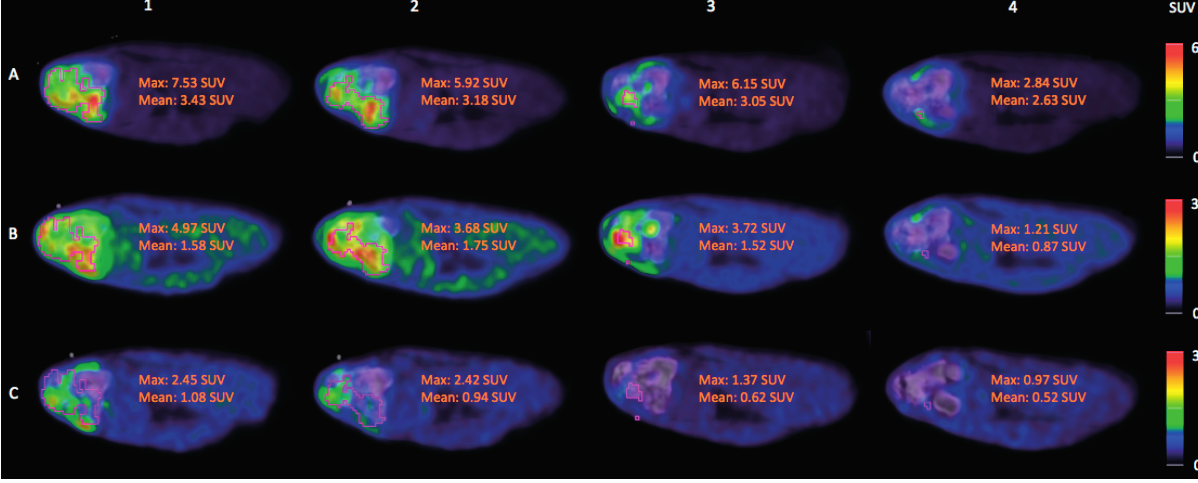
Figure 1. PET/CT images of the tumor area in the left proximal tibia, transverse plane. Both uptake magnitude and distribution are different between the three tracers. Column 1 : Before radiotherapy; Column 2 : After 22.5 Gy of radiotherapy; Column 3 : After 45 Gy of radiotherapy (at completion of radiotherapy); Column 4 : 10 weeks after completing radiotherapy. Row A : 18 F-FDG PET/CT; Row B : 18 F-FLT PET/CT; Row C : 64 Cu-ATSM PET/CT 6.5 h after intravenous injection. Pink angular lines demarcate 3D iso-contouring lines for the tumor volume of interest (VOI) defined by a standardized uptake value (SUV) cut-off at 2.5 for 18 F-FDG ( 18 F-FDG SUV 2.5 volume). First delineated on the 18